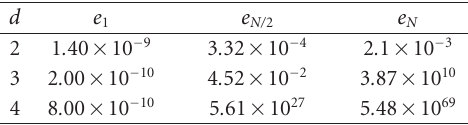
Table 6.5. Approximate error for Example 6.2.